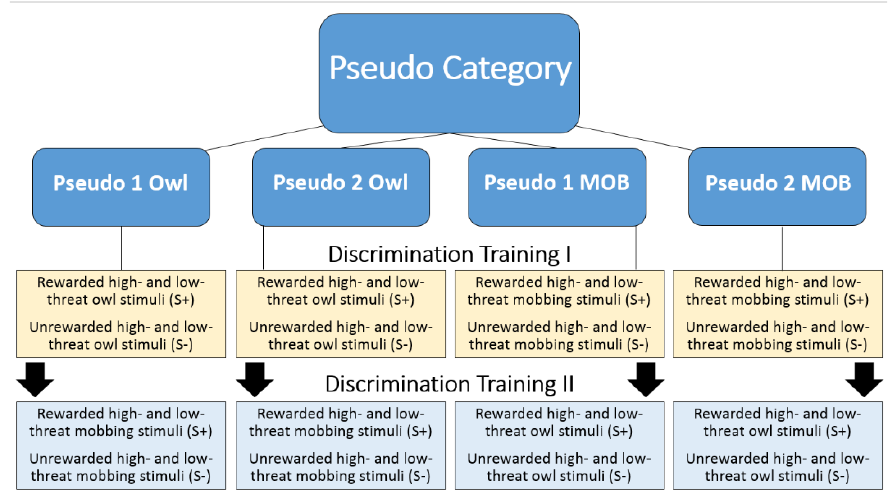
Schematic of the Stimulus Types and Reward Contingencies for Discrimination Training I and Discrimination Training II for the Four (4) Subgroups of the Pseudo Category